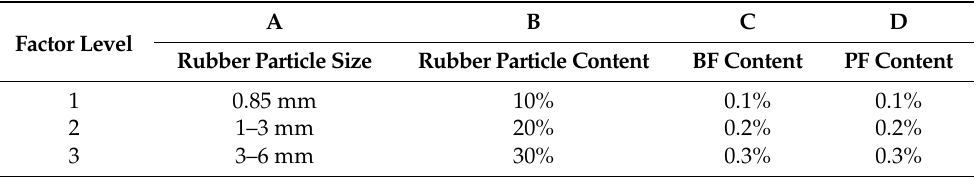
Table 6. Factor and level of the orthogonal experiments.